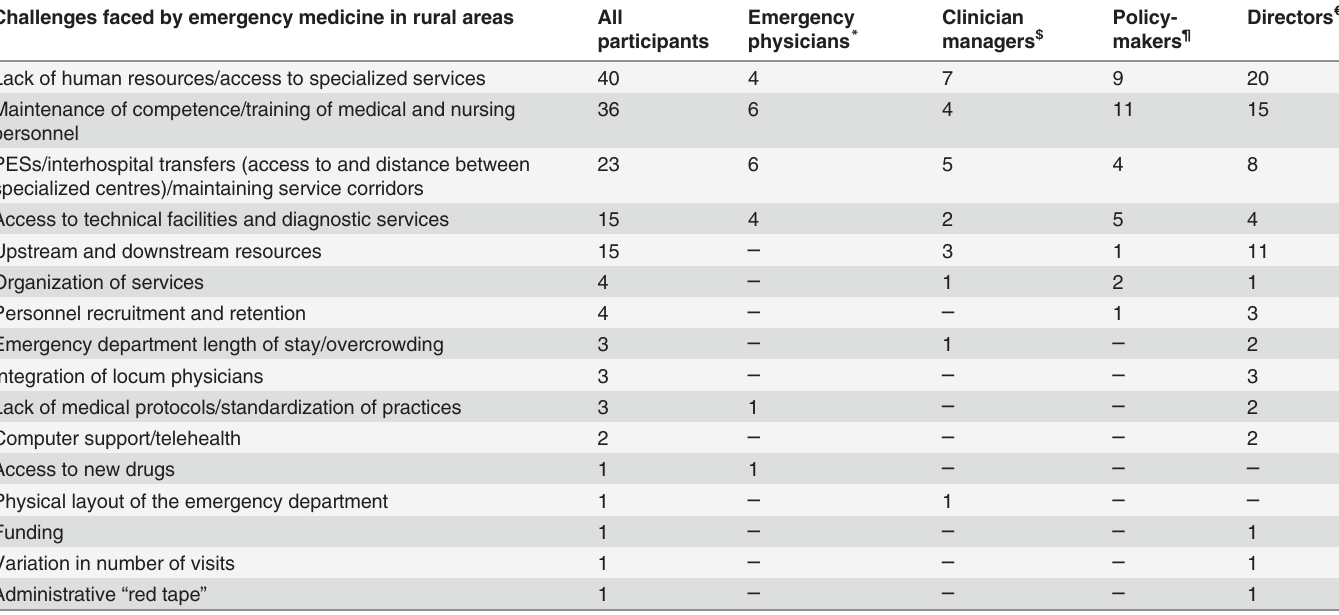
Table 3. Frequency of citing for challenges faced by emergency medicine in rural Quebec (by entire sample and by job category). Challenges faced by emergency medicine in rural areas All